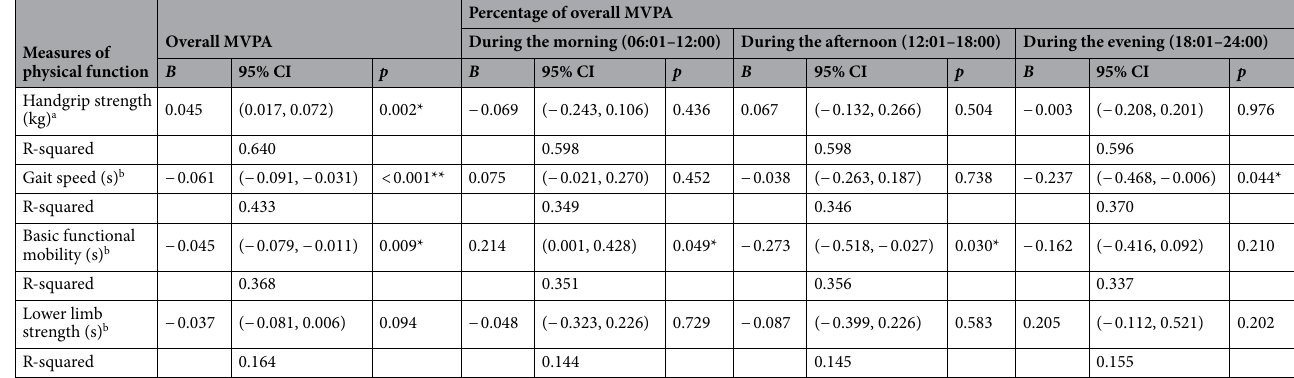
Table 2. Associations of overall and timing-specific moderate-to-vigorous physical activity with measures of physical function. B unstandardized linear regression coefficient, MVPA moderate-to-vigorous physical activity, CI confidence interval. a A positive association indicates better physical function accompanied by more time spent in MVPA. b A positive association indicates worse physical function accompanied by more time spent in MVPA. * p < 0.05; ** p <